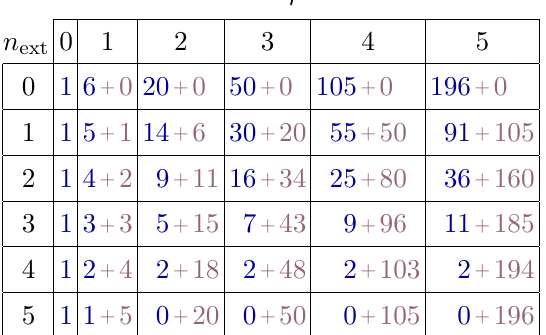
Table 2 . Division of numerator degrees of freedom consisting of r powers of inverse propagators into non-contact vs. contact terms for integrands involving n ext external propagators.